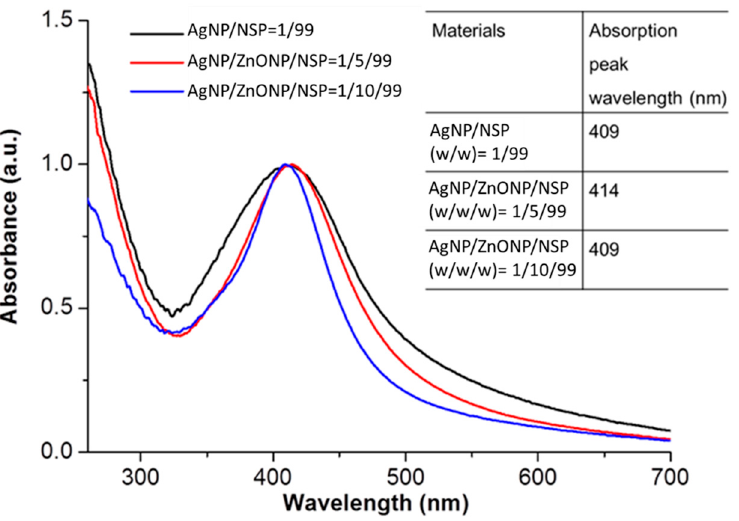
Figure 5. UV-Vis absorption of AgNP/NSP (1/99, w / w ) and AgNP/ZnONP/NSP (1/5/99 and 1/10/99, w / w / w ). Abbreviations: AgNP, silver nanoparticle.